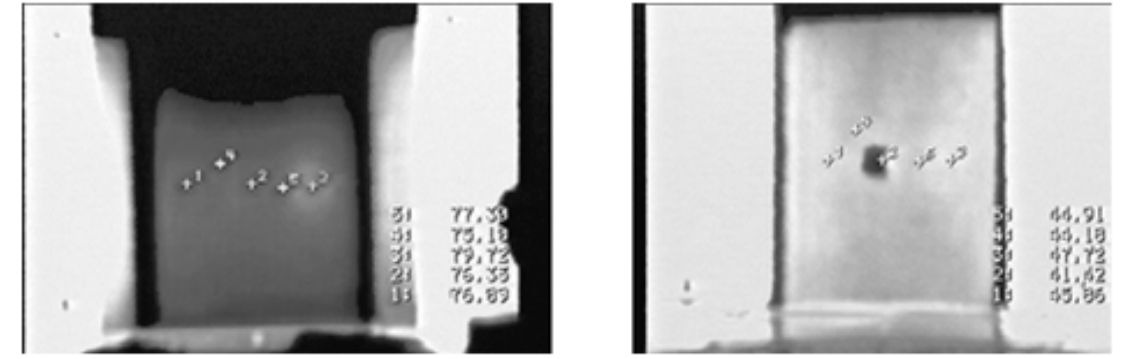
Figure 5. Thermograms of two different investigated samples.